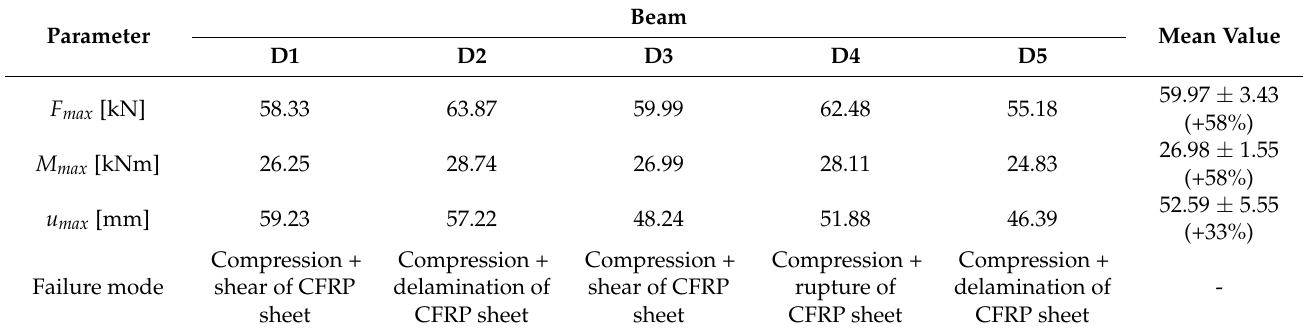
Table 8. Series D test